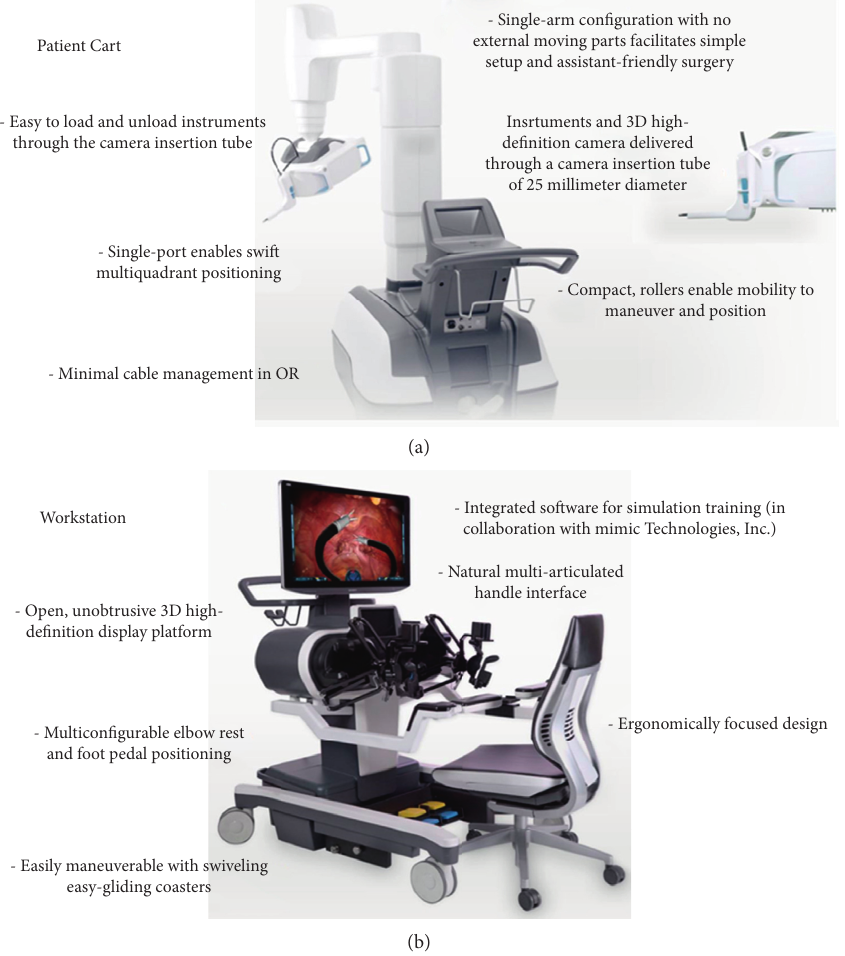
Figure 5: SPORT ™ , Titan Medical Robotic Surgical System; (a) Patient’s cart; (b) surgeons workstation; Copyright Titan Medical Inc.